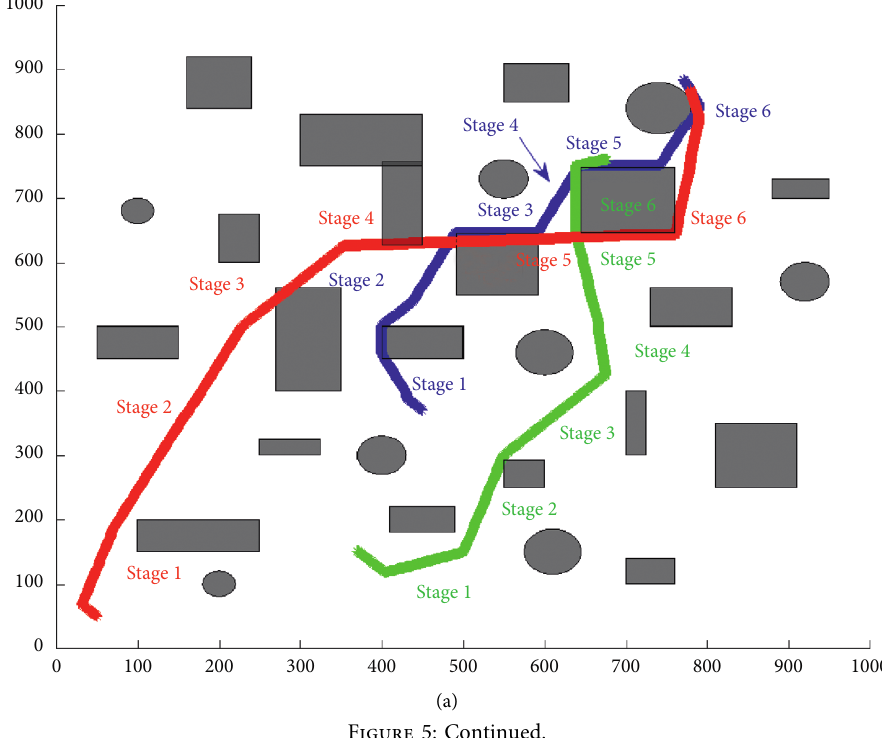
Figure 4: Subgoals of P and P on cuboid obstacle. (a) When E just disappears, the pursuit of P 1 2 is in pursuit of P 1